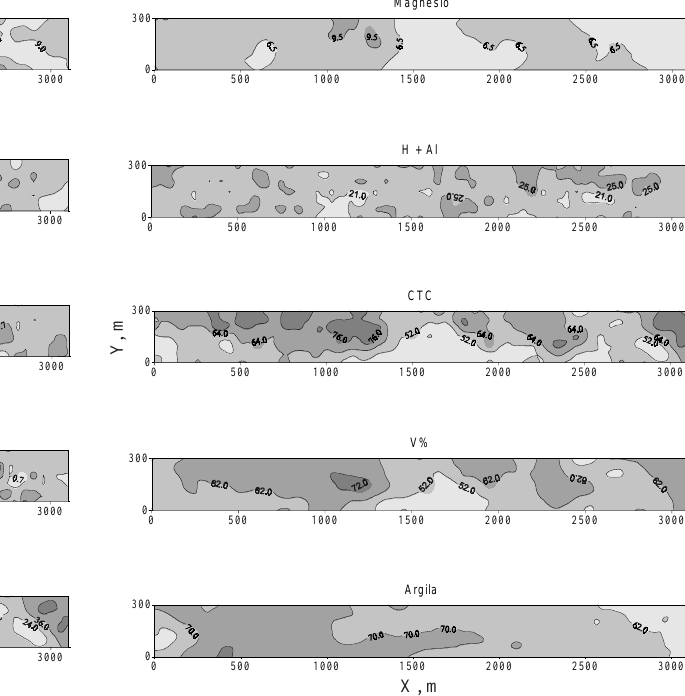
Figura 4. Mapas de isolinhas dos atributos Mg 2+ , H + Al, CTC, V % e teor de argila, na profundi- dade de 0,60–0,80